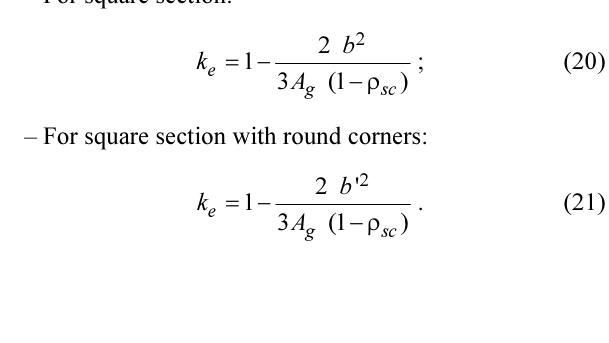
Table 8. Data and results of CFRP-confined square concrete specimens